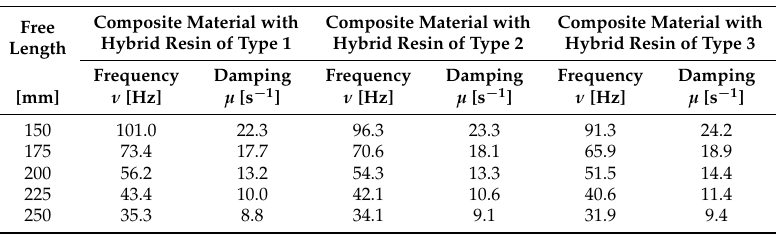
Table 8. The behavior under vibrations of samples from composites with matrix of hybrid resin of type 1, 2 and 3, reinforced with the second type of flax